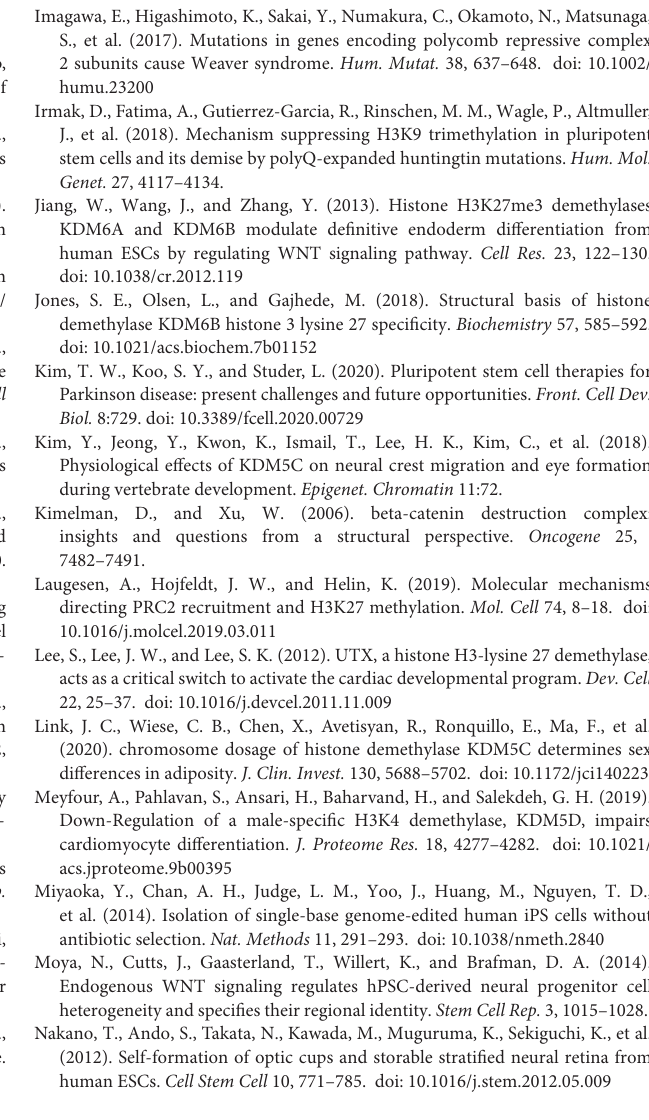
Supplementary Figure 1 | The expression dynamics of KDM6B and KDM6A during neural differentiation based on LIBD Stem Cell Browser. The diagram is from the website (http://stemcell.libd.org/scb/) with minor modifications. Supplementary Table 1 | TPM analysis of RNA-seq